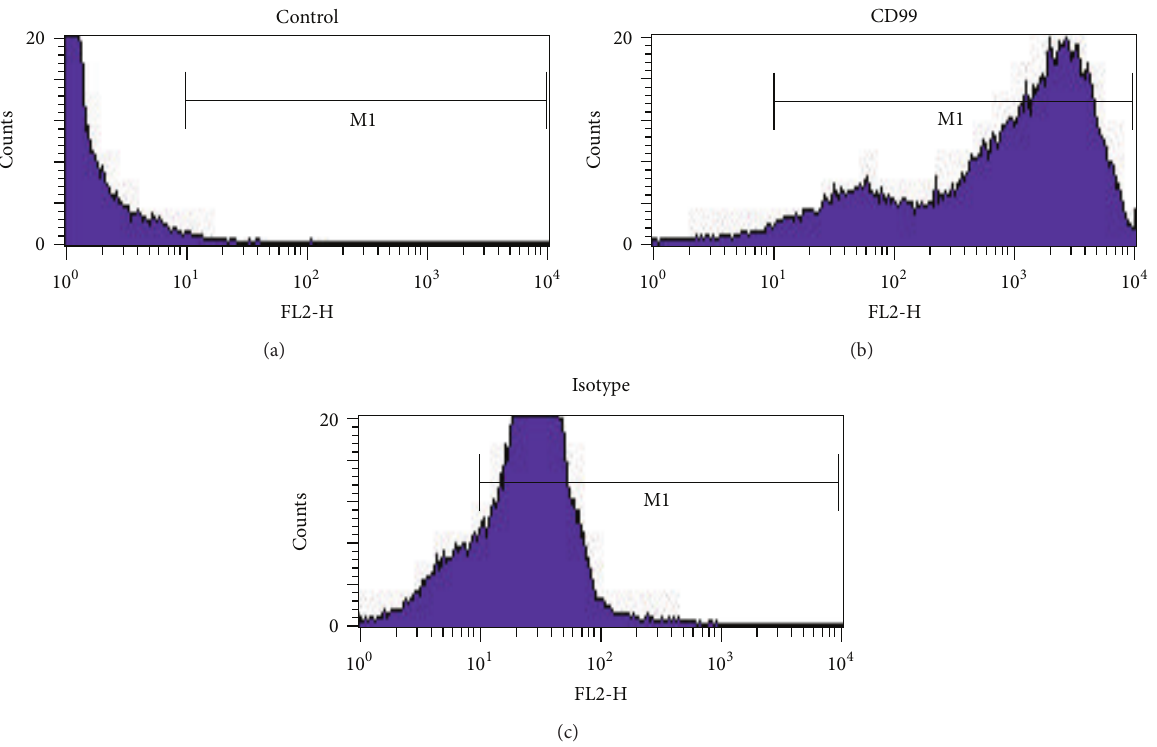
Figure 2: Cell line derived from the EWS biopsy is CD99 positive. After several passages, the established cell line was incubated with CD99 polyclonal antibody conjugated to fluorescein or corresponding isotype control and processed through a Fluorescent Activated Cell Sorter (FACS) as per manufacturers recommendations (R&D Systems Catalog number FAB3968F, or isotype control Catalog number